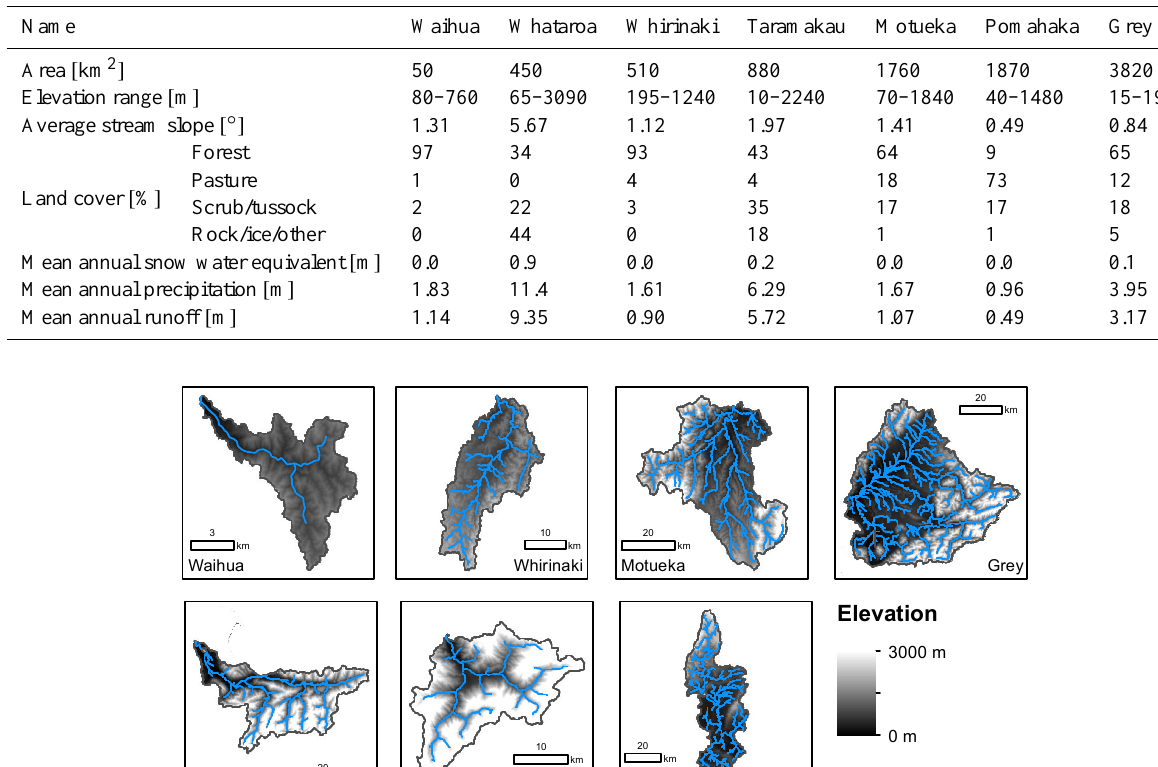
Table 1. Catchment